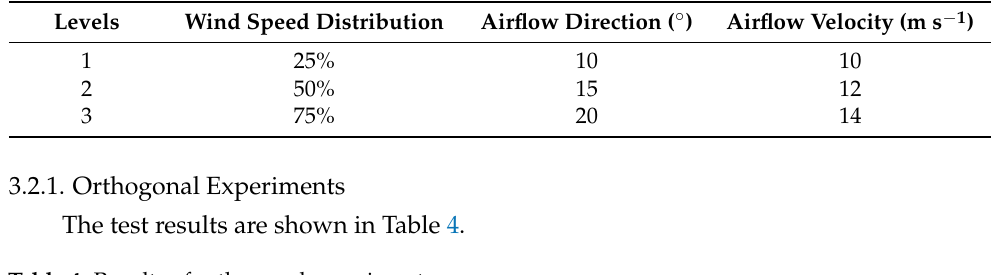
Table 4. Results of orthogonal